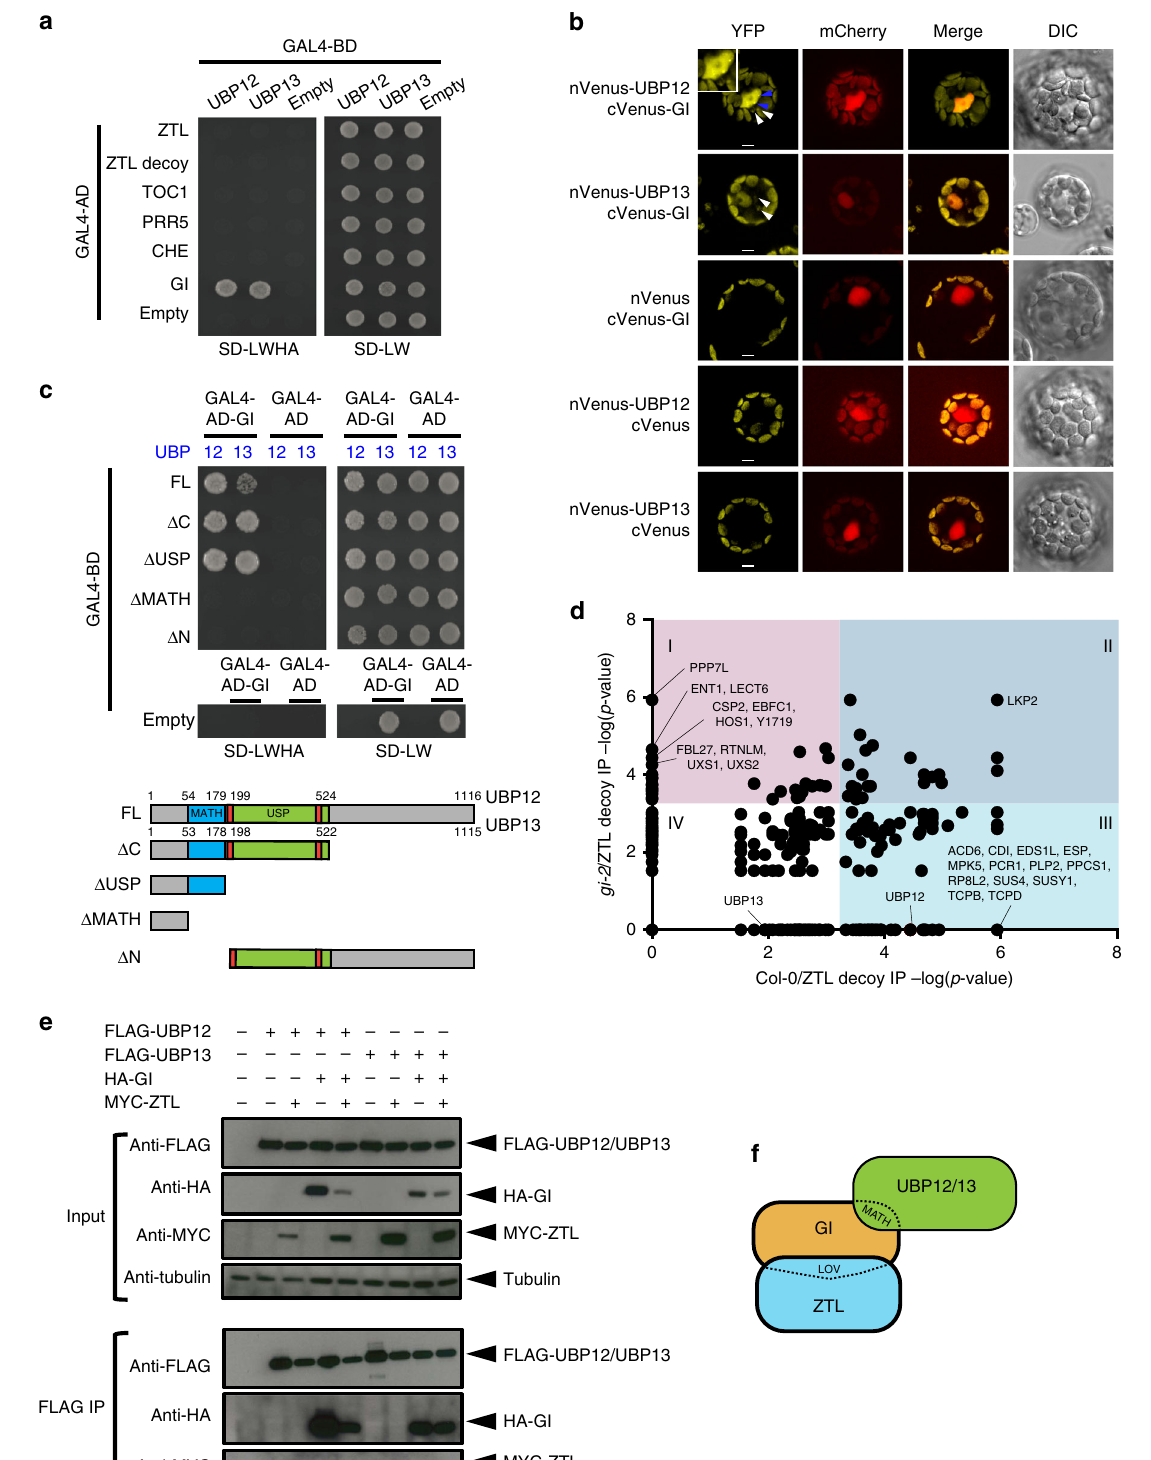
period with period lengths that varied from 0.4 to 1 h shorter than wild type. We next generated ubp12-1/gi-2 and ubp13-1/gi-2 double mutants and measured the expression of the core clock gene CCA1 during a 2-day circadian time course in constant light using quantitative reverse-transcription PCR (qRT-PCR) (Fig. 2e, f and Supplementary Table 1). LS Periodogram analysis using the Biodare2 platform [biodare2.ed.ac.uk 33 ] showed that the ubp12-1/